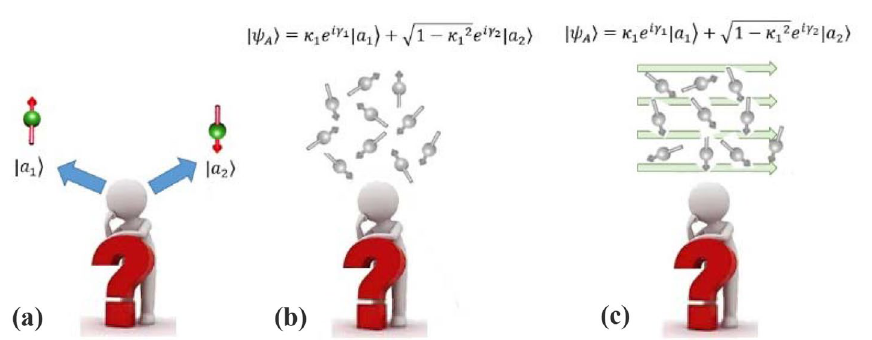
Figure 4. According to BEQBN, humans made their decisions by interpreting the information for each choice separately in the absence of uncertainty ( a ) or by thinking about two choices simultaneously ( b and c ) under uncertainty. Also, this model considers a biased decision-making process inspired by electric fields when the probabilities of finding the system in two options are not equal ( c